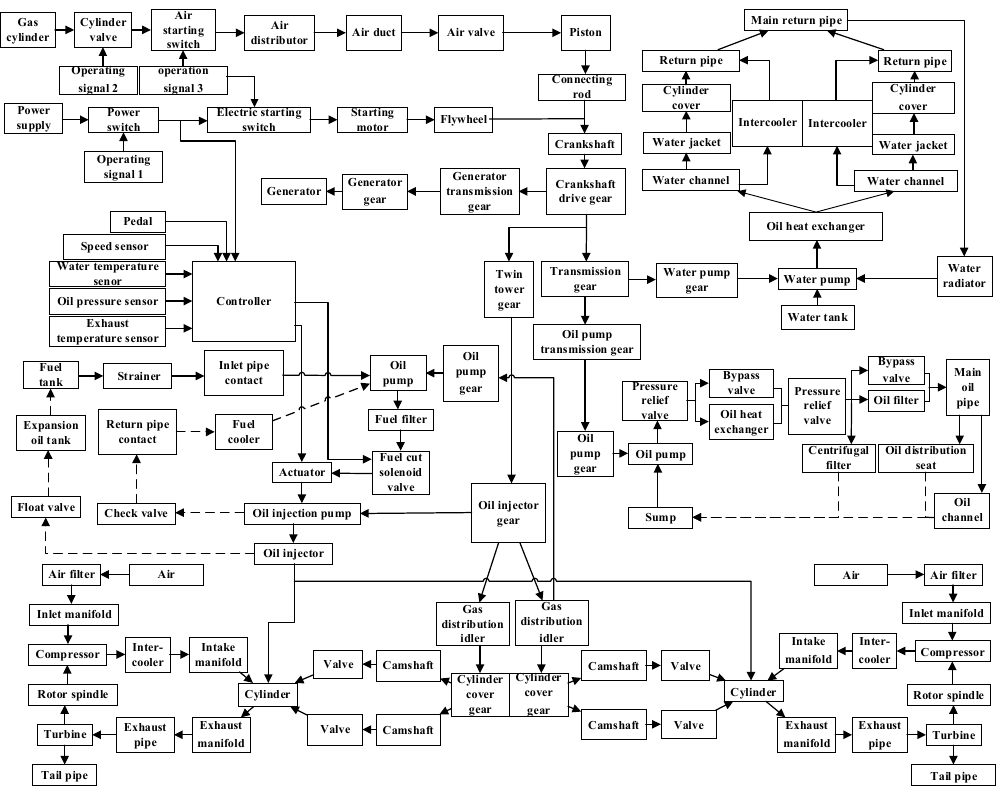
Figure 2. Operating principle of the diesel engine system.